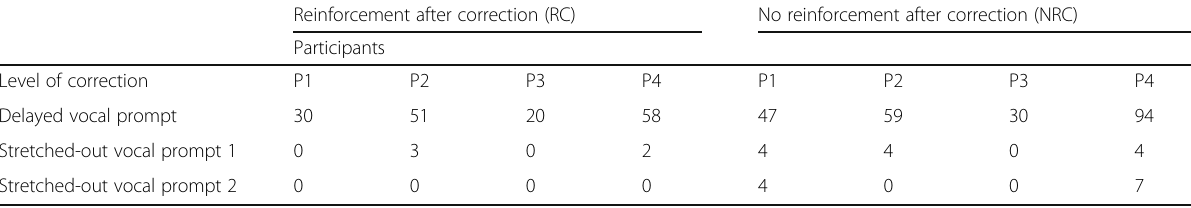
Table 1 Level and frequency of correction needed in RC and NRC conditions for each participant Reinforcement after correction